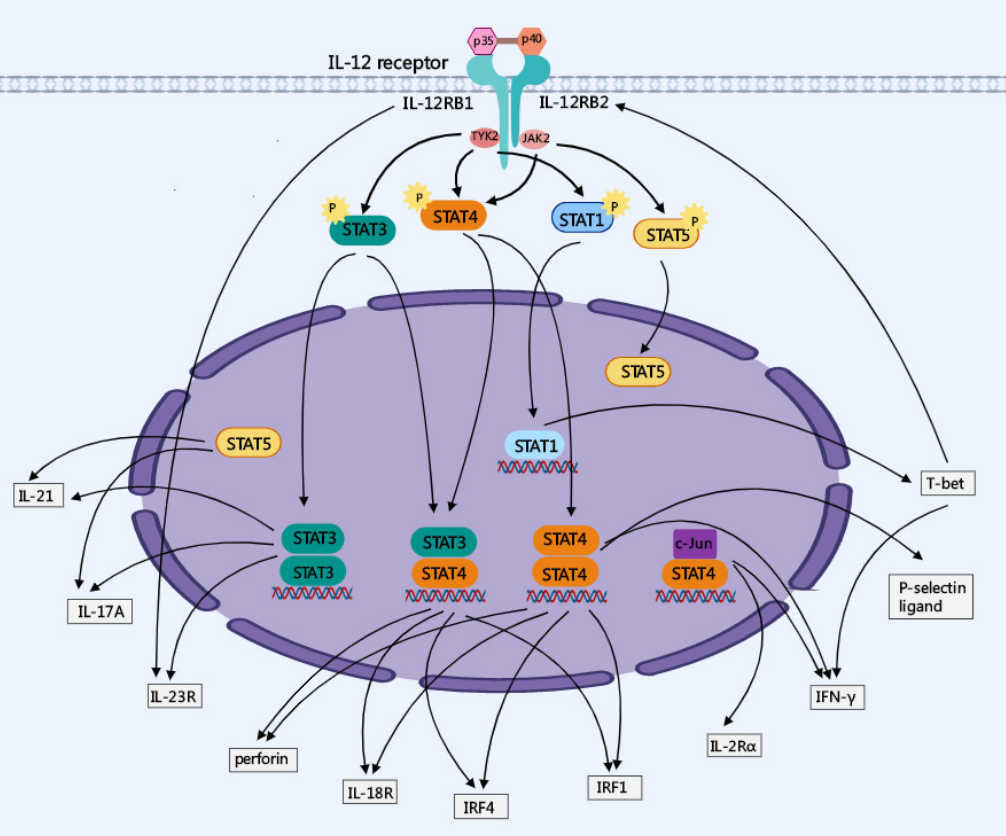
Figure 1. IL-12-related signaling pathway. IL-12 is unique in having the only heterodimeric cytokines, which are composed of an α -chain (p35) and a β -chain (p40). IL-12 signals via its receptor IL-12RB1 and IL-12RB2 are mediated by members of the JAK-STAT family which mediate the expression of downstream proteins, such as IL-21, IL-17A, IL-23R, IL-18R, IL-2R α , T-bet and IFN- γ .